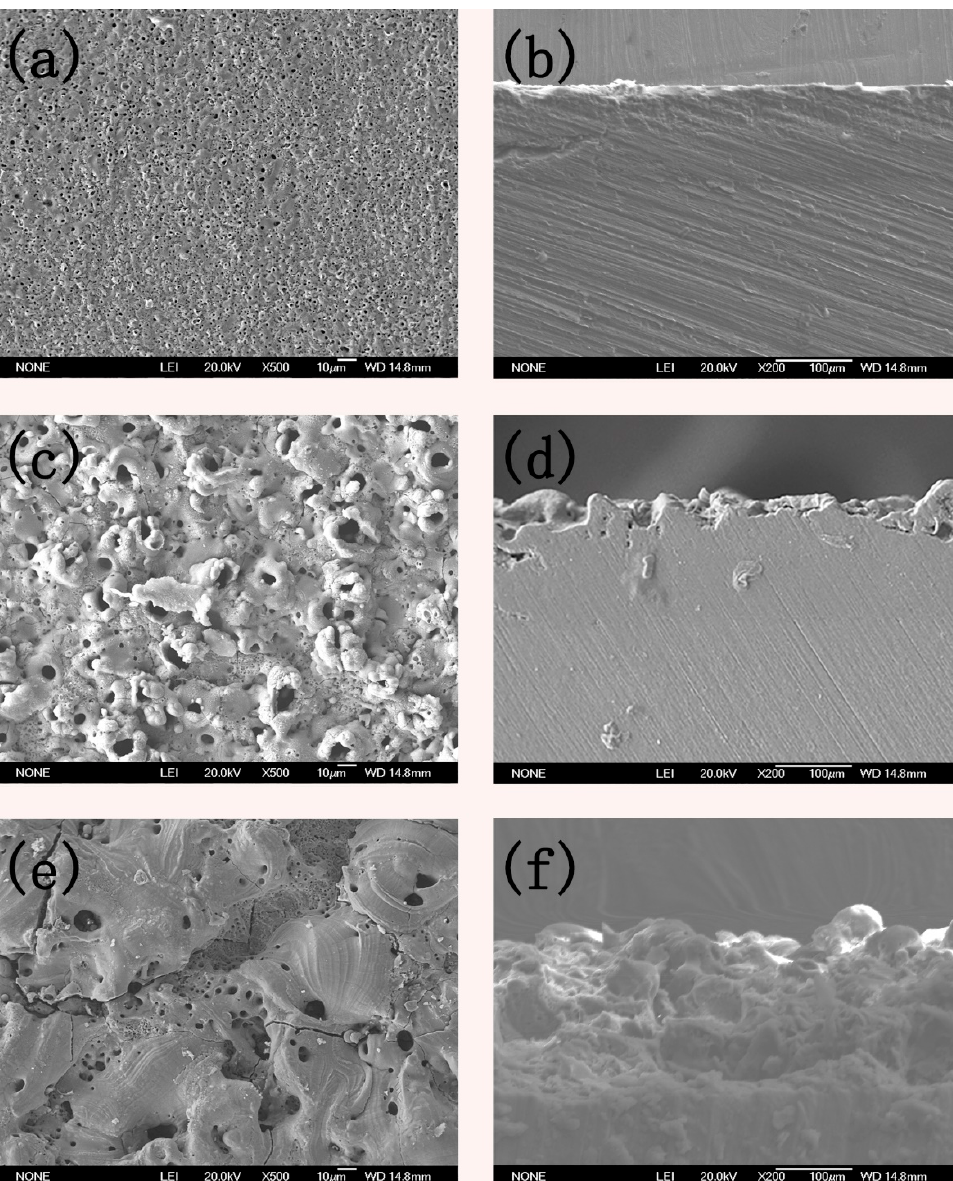
Figure 6. Micro-morphology ( a , c , e ) and cross section ( b , d , f ) of APD coating at current density of 10 mA ( a , b ), 20 mA ( c , d ) and 50 mA ( e , f ).